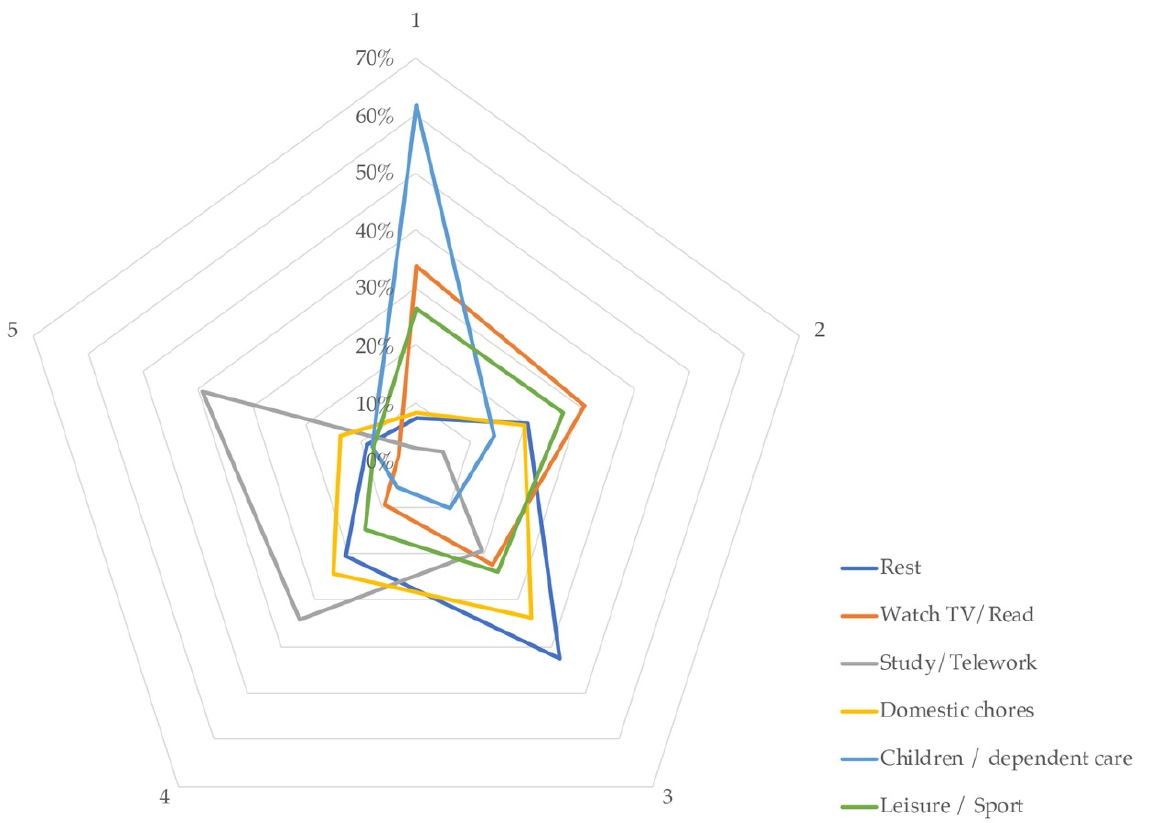
Figure 8. Time-dedication distribution of participants to activities at home, in COVID-19